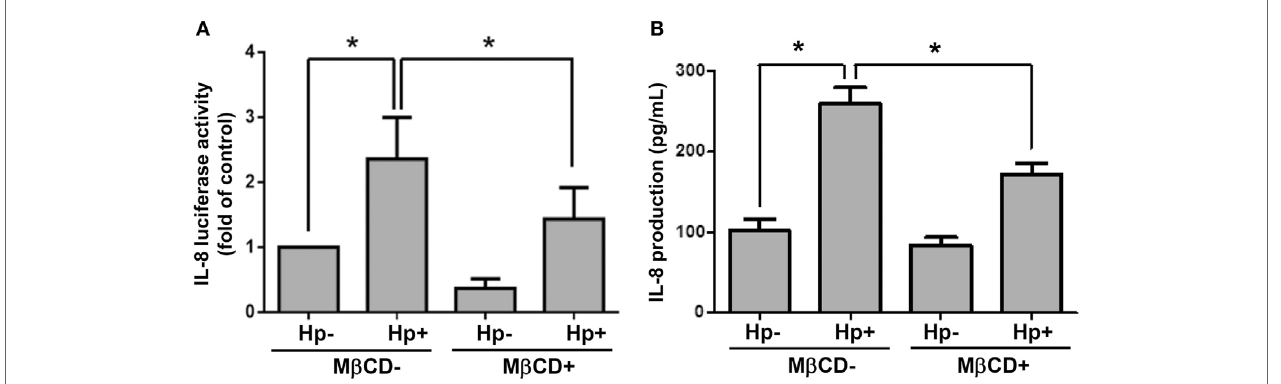
FigUre 8 | Disruption of lipid rafts reduces H. pylori -induced il-8 production . AGS cells were transfected with an IL-8 luciferase reporter in the absence or presence of 5 mM M β CD prior to infection with H. pylori (MOI = 100) for 6 h. (a) Cell lysates were subjected to luciferase activity assay to assess IL-8 promoter activity. (B) IL-8 secretions in the cell culture supernatants were assessed by ELISA. Statistical significance was evaluated by Student’s t -test (* P <